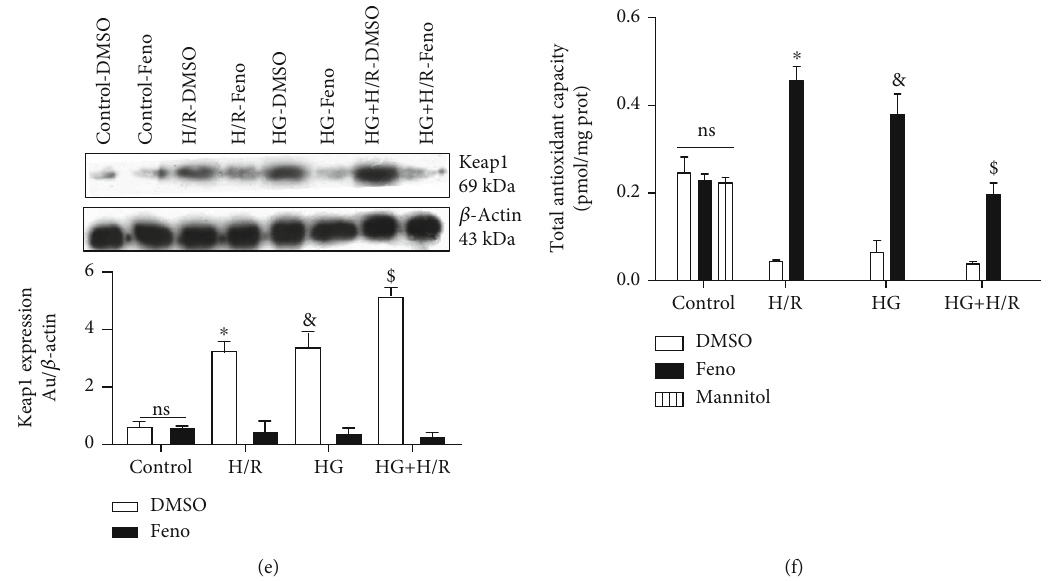
Figure 5: Feno fi brate (10 μ M) increased antioxidant defense in primary cultures of cardiomyocytes subjected to hypoxia/reperfusion (H/R), high glucose (HG), or the combination of conditions (HG+H/R). Protein expression by Western blot and densitometric analysis of (a) SOD Cu 2+ /Zn 2+ , (b) SOD Mn 2+ , (c) catalase, (d) Nrf2, (e) Keap1, and (f) total antioxidant capacity. ND = not detectable; DMSO = dimethylsulfoxide (0.1%); Feno = feno fi brate (10 μ M). # p < 0 : 05 vs. control-DMSO; ∗ p < 0 : 0 5 vs. H/R-DMSO; & p < 0 : 05 vs. HG-DMSO; $ p < 0 : 05 vs. HG+H/R-DMSO. Values represent the mean ± SEM of 6 di ff erent experiments. Two-way analysis of variance (ANOVA) followed by Tukey ’ s post hoc test.